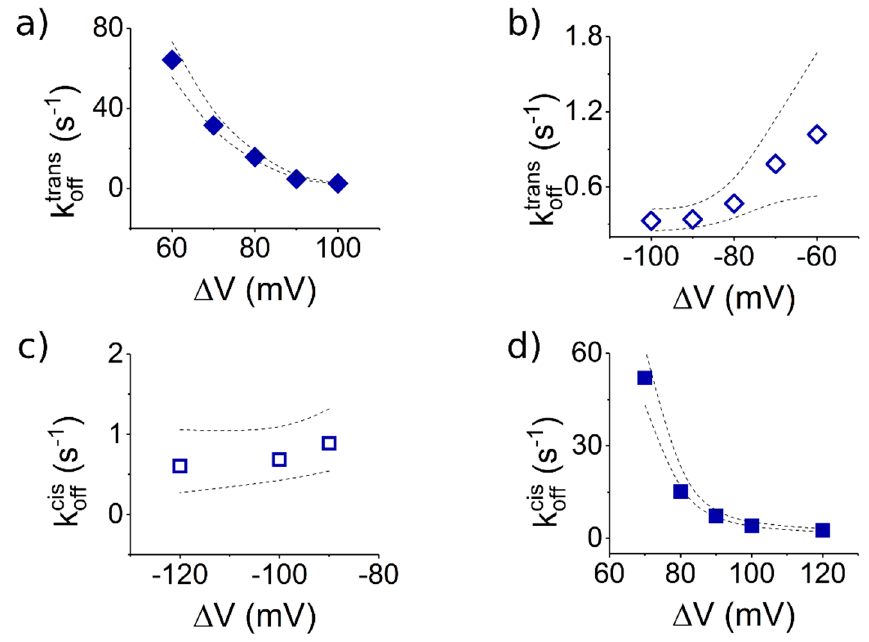
Figure 7. Dissociation rates of S 6 -containing peptides from the α -HL depend on the polarity of the applied Δ V and the side on which they are added ( cis or trans ). All the graphs display the voltage-dependent dissociation rate constants ( k off ) of the Pe6 peptide [30 µ M] from the α -HL. As in Figure 5: ( a , b ) the peptides were added to the trans side; and ( c , d ) the peptides were added on the cis side. The dotted lines represent the upper and lower limits of the 95% confidence intervals for the estimated average values [40].